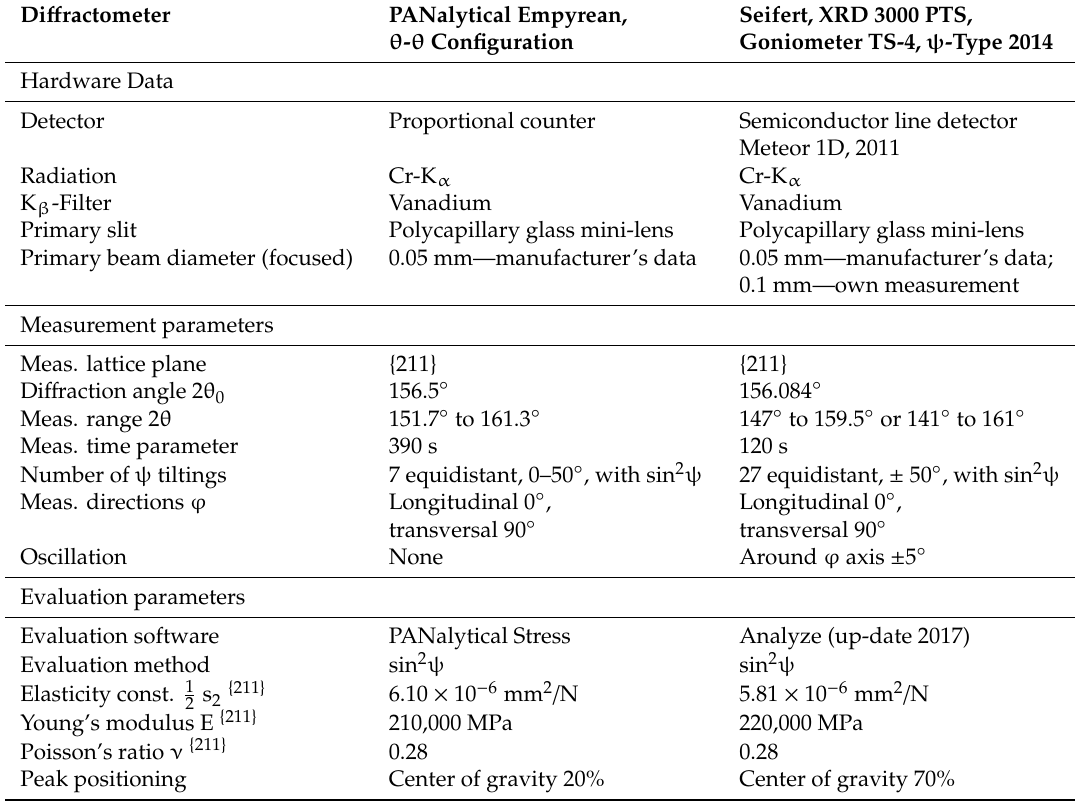
Table 4. X-ray di ff raction set up of di ff ractometers PANalytical Empyrean and Seifert, XRD 3000